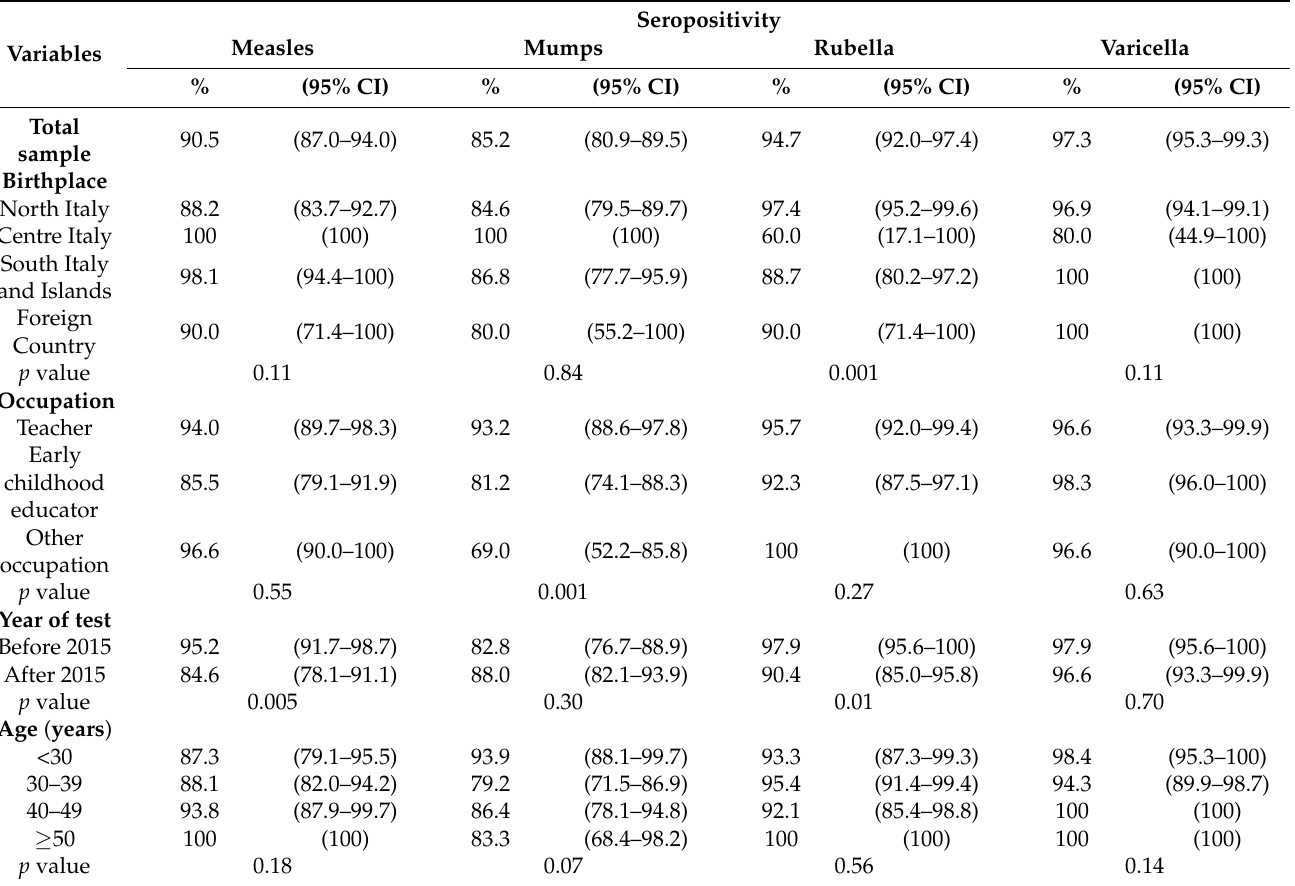
Table 2. Distribution of the seropositivity of measles, mumps, rubella and